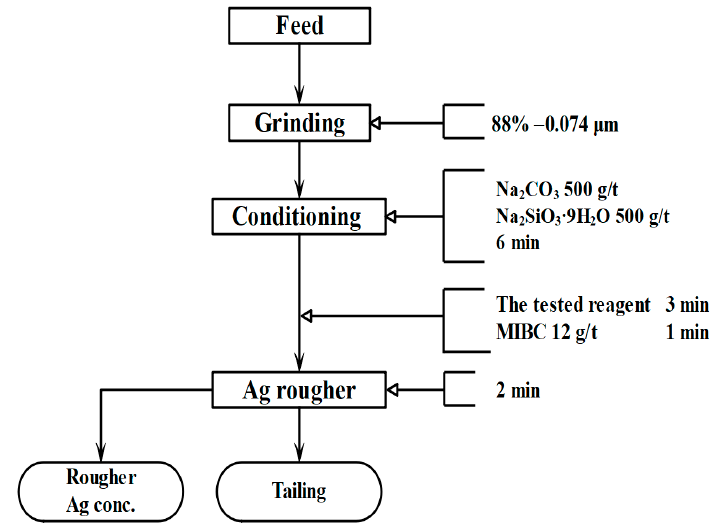
Figure 4. Flowchart of the Ag collector test.